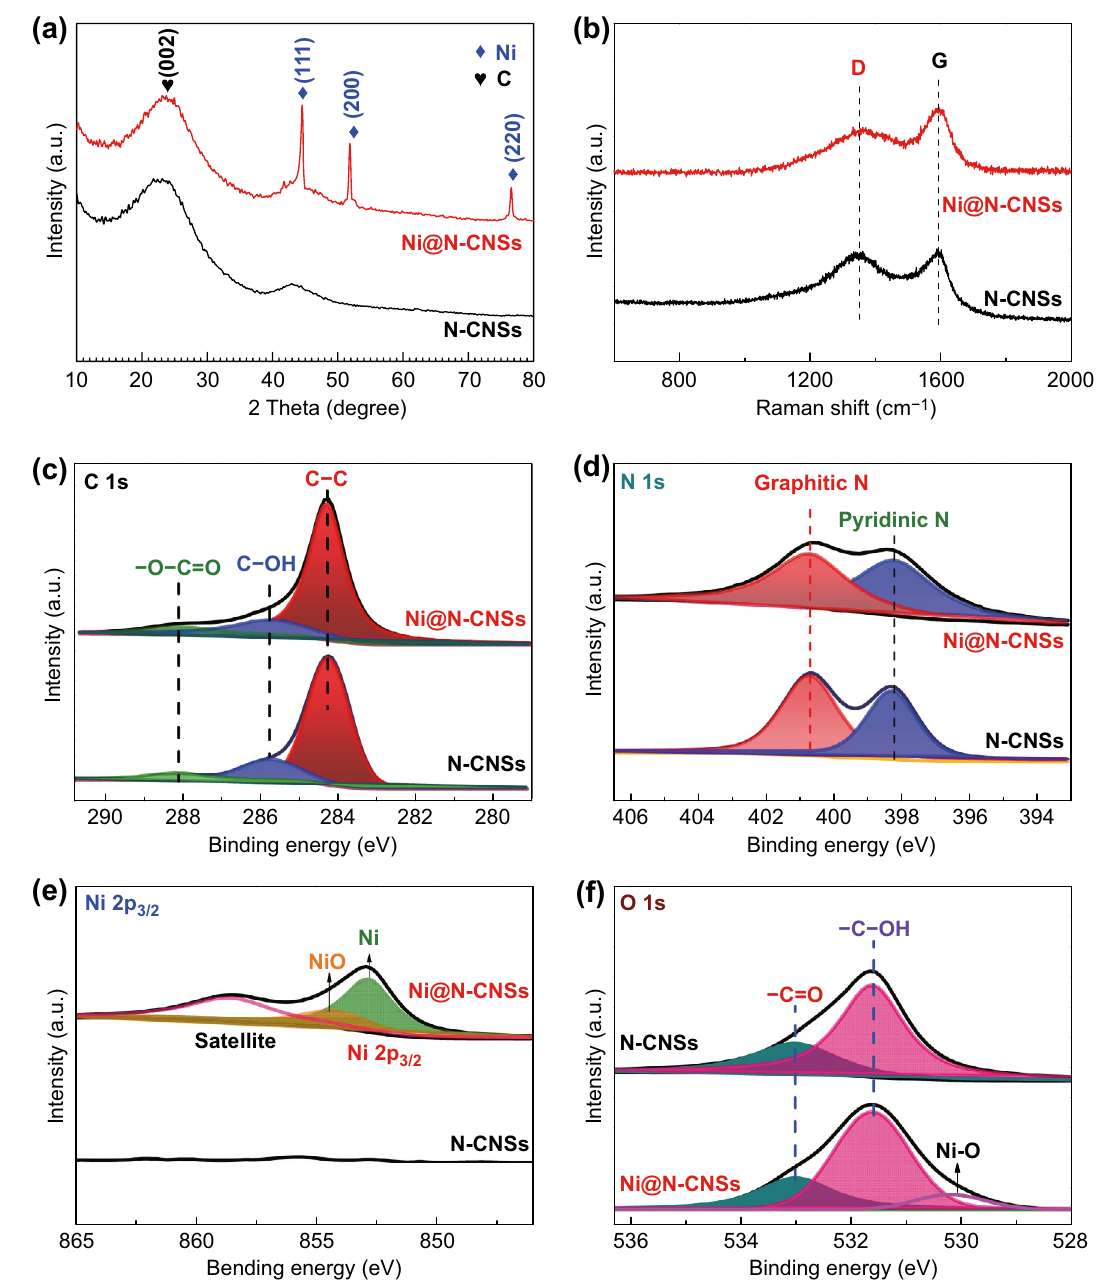
Fig. 3 Phase and composition characterization. a XRD patterns; b Raman spectra; XPS test: c C 1 s spectra; d N 1 s spectra; e Ni 2 p spectra; and f O 1 s spectra of N-CNSs and Ni@N-CNSs